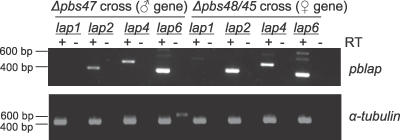
RT-PCR Analysis of pblap Expression in Day 10 OocystsRT-PCR on total RNA isolated from midguts of An. stephensi infected with Δpblap1 × Δpbs47 (lanes 1 and 2), Δpblap2 × Δpbs47 (lanes 3 and 4), Δpblap4 × Δpbs47 (lanes 5 and 6), Δpblap6 × Δpbs47 (lanes 7 and 8), Δpblap1 × Δpbs48/45 (lanes 9 and 10), Δpblap2 × Δpbs48/45 (lanes 11 and 12), Δpblap4 × Δpbs48/45 (lanes 13 and 14), and Δpblap6 × Δpbs48/45 (lane 15 and 16). Top panel, PCR for the respective pblap gene as indicated above the panel; bottom panel, control PCR for a-tubulin; RT, reverse transcriptase. Fragments of the expected size were amplified for pblap2 (399 bp), pblap4 (482 bp), pblap6 (381 bp), and α-tubulin (432 bp). A weak signal for pblap1 (540 bp) was observed on longer exposures in both crosses. Some genomic DNA contamination was detected for Δpblap6 × Δpbs47 (lane 8, bottom panel), but the pblap6 PCR product from cDNA (lane 7, top panel) can be distinguished from amplification of genomic DNA by the absence of a 310-bp intron.